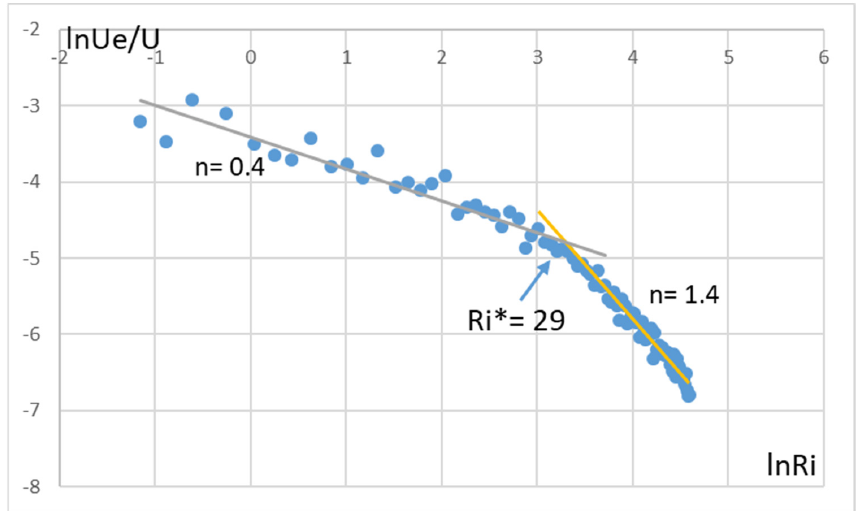
ln(cid:1847) (cid:3032) (cid:1847)(cid:3415) on ln(cid:1844)(cid:1861) for the experimental run with the initial value of Figure 3. Dependence of Figure 3. Dependence of ln U e / U on ln Ri for the experimental run with the initial value of (cid:1844)(cid:1861) (cid:3036)(cid:3041)(cid:3036)(cid:3047)(cid:3036)(cid:3028)(cid:3039) = 100 and (cid:1844)(cid:1857) = 214 . The straight lines show two different asymptotic power depend- Ri initial = 100 and Re = 214. The straight lines show two different asymptotic power dependences. ences. Their intersection point at (cid:1844)(cid:1861) ∗ indicates to the abrupt transition from one dependence to the Their intersection point at Ri ∗ indicates to the abrupt transition from one dependence to the other.